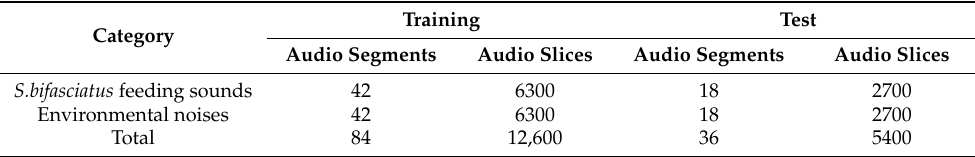
Table 1. The statistics of the dataset.